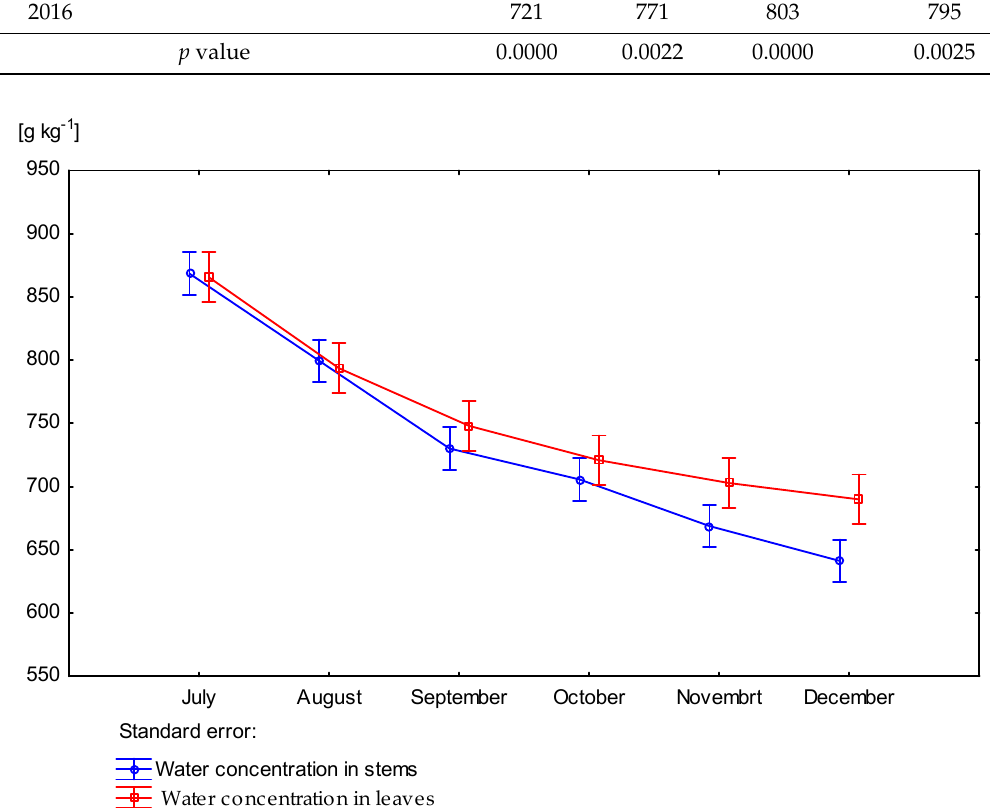
Figure 5. Water concentration in leaves and stems during the vegetation period of the years 2014–2016 (average for years).